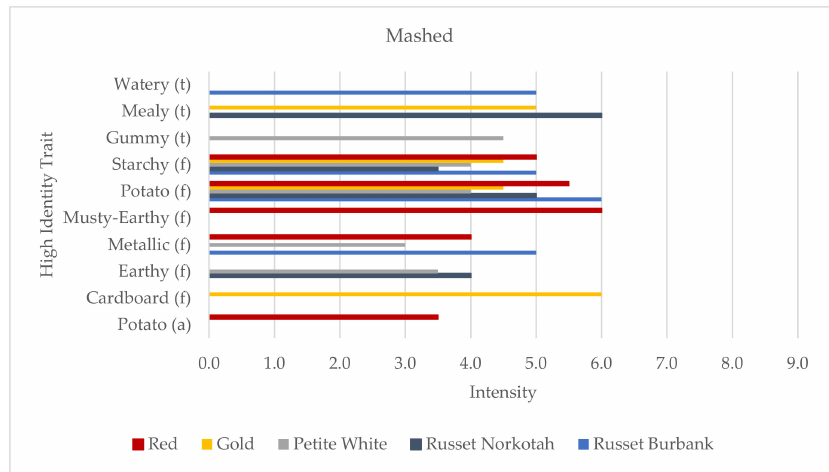
Figure 2. High identity traits (HITs) profiles of the mashed potato samples (aroma (a), the “smell” of the product; flavor (f), tastes, aromatics, and feeling factors while food is being eaten by the mouth; and texture (t)). Intensity was rated on a 0–15 scale with 0.5